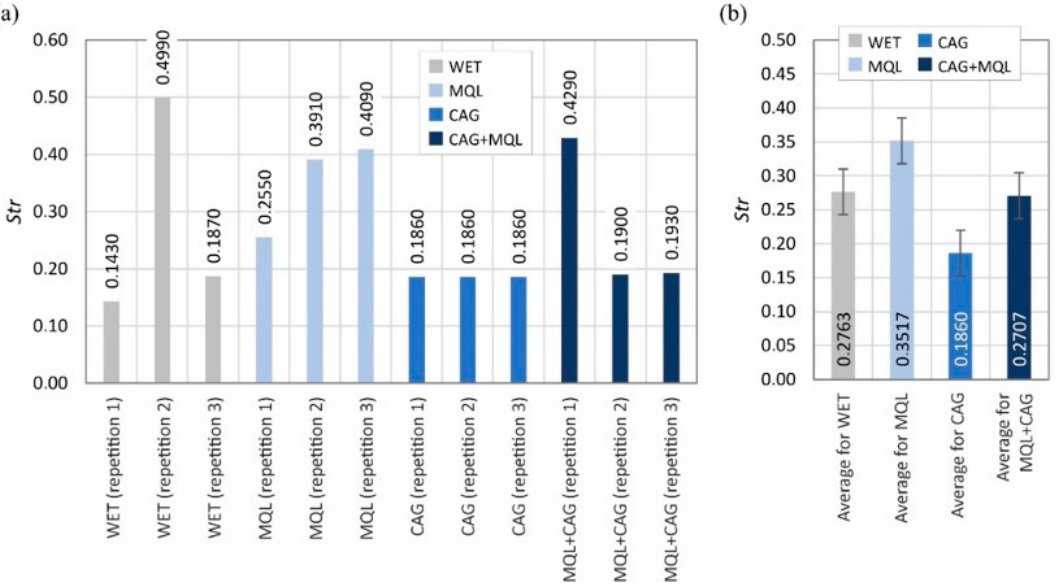
Figure 11. Chart of changes in the texture aspect ratio of the surface Str : ( a ) results for the twelve blades selected for the surface texture measurements; ( b ) mean values of the parameters divided by cooling and lubrication methods of the grinding zone used during the shaping of the blades (error bars represent the standard error equal to the standard deviation σ divided by the square root of the total number of samples).